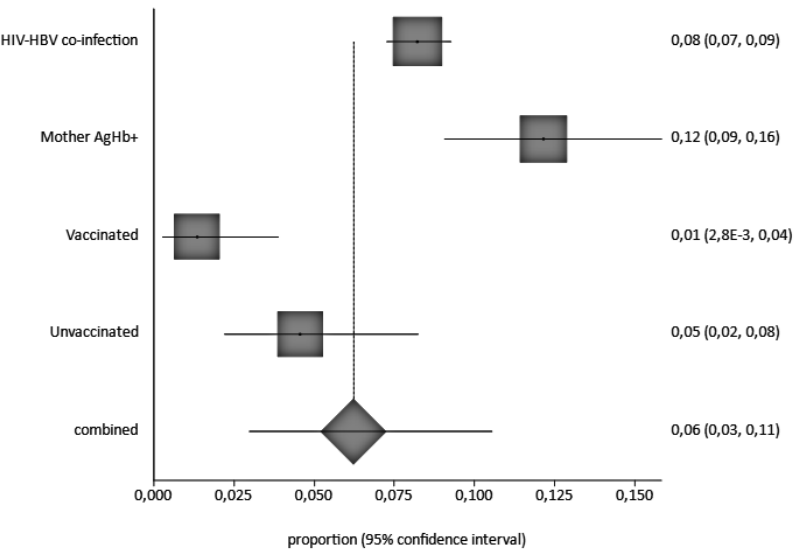
Figure 6. Pooled HBV Infection Prevalence by Risk Factor A black square represents the HBV pre- valence in the forest plot. The square position represents the prevalence.